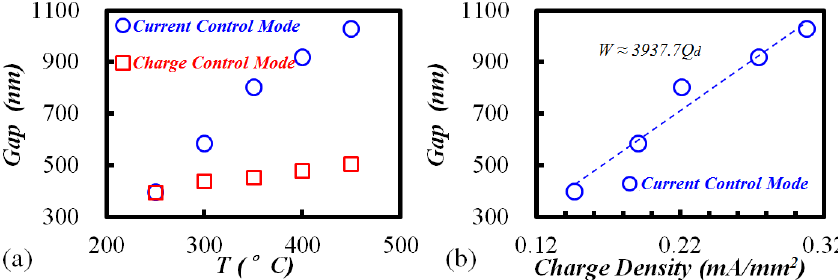
Figure 2. With temperature 350 °C and 10 min etching: ( a ) gap width vs. bonding voltage; ( b ) gap width vs. charge density.